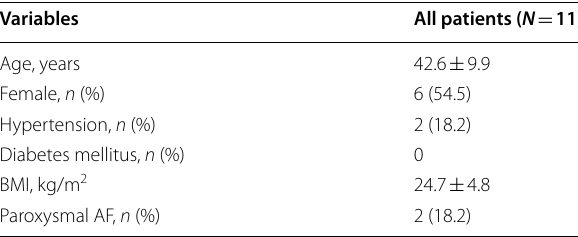
Table 1 Baseline patient characteristics Table 2 Conventional echocardiographic parameters